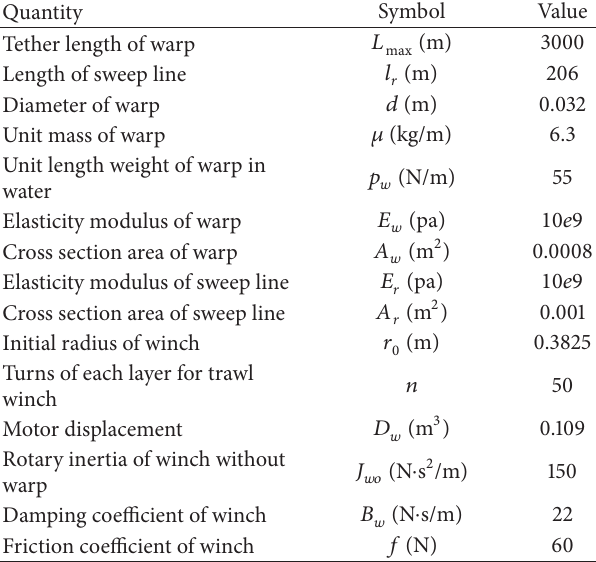
Table 2: Warp, sweep line, and trawl winch model parameters.